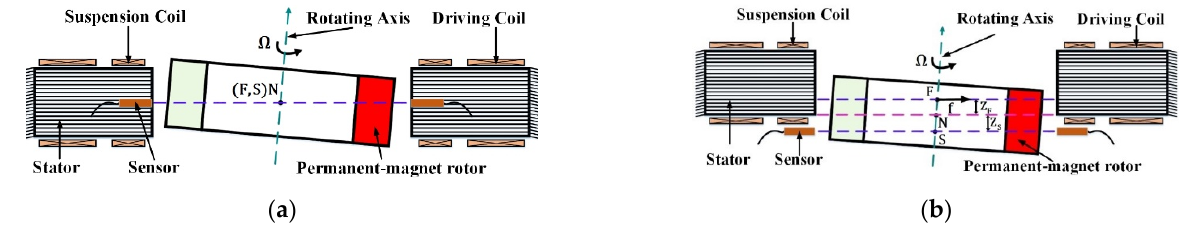
Figure 4. Schematic diagram of MLSM with ( a ) collocated structure; ( b ) non-collocated structure.